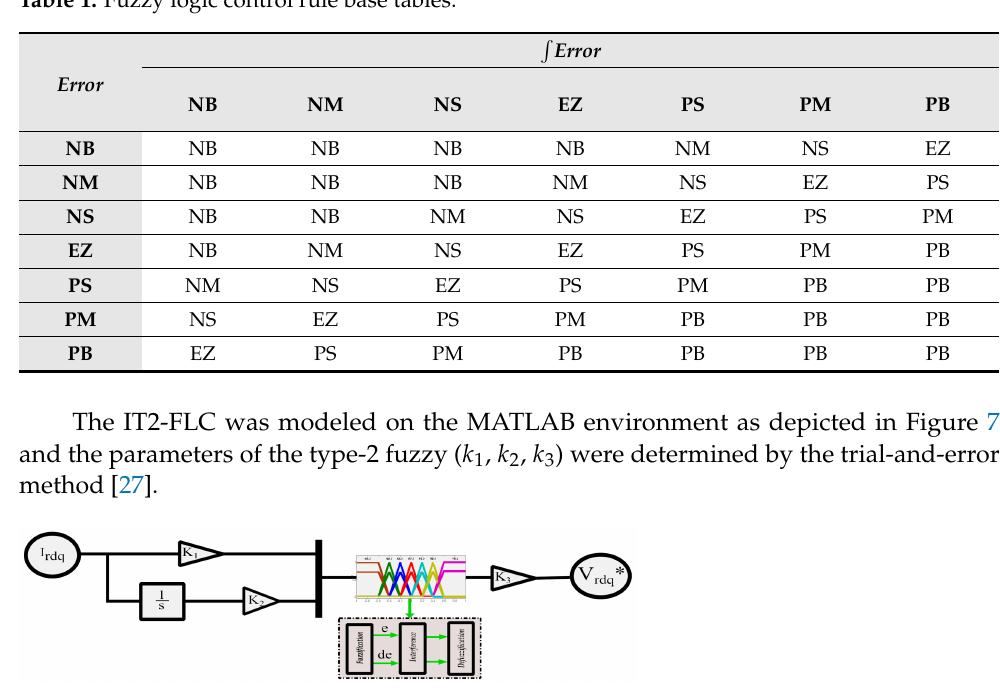
Figure 7. Schematic model of the interval type-2 fuzzy controller (IT2-FLC).